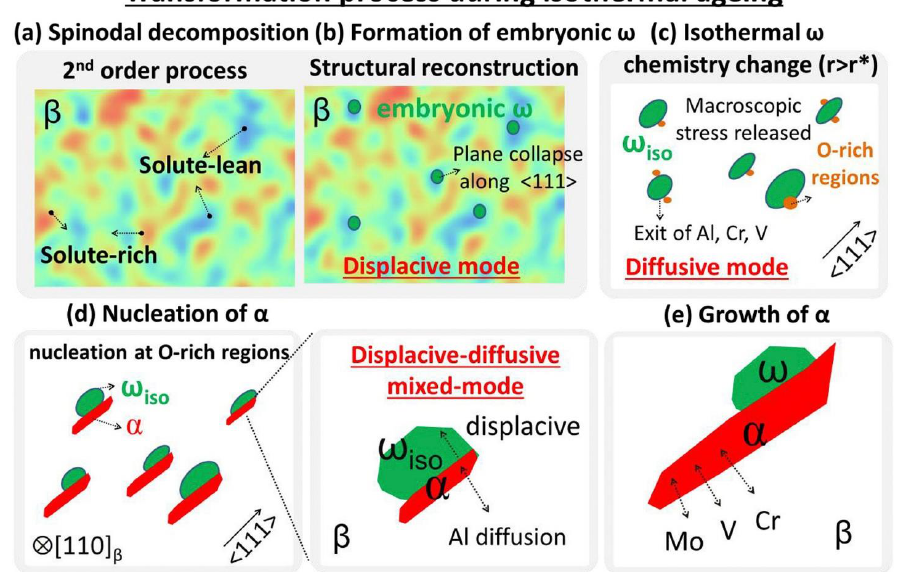
Figure 13. The phase transformation pathway from embryonic ω -phase, to isothermal ω -phase, to secondary α -phase precipitates during isothermal aging is illustrated [132]. ( a ) 2nd order coherent β -phase spinodal decomposition, ( b ) ω -phase embryos forms within certain composition range, where the structural evolution of embryonic ω -phase involves the displacement along the <111> direction, ( c ) when the size of embryonic ω -phase reaches a critical value, transformation from embryonic to isothermal ω -phase occurs via a diffusive mode, ( d ) O-rich regions present at the interface between isothermal ω -phase and β -phase matrix act as nucleation sites for α -phase, the transformation from ω -phase to α -phase involves lattice reconstruction as well as the diffusion of Al, ( e ) as the α -phase grows, the diffusion of Mo, V and Cr increases between α -phase and β -phase matrix. (Reprinted with permission from Acta Materialia, vol. 106, no. 12, T. Li et al., New insights into the